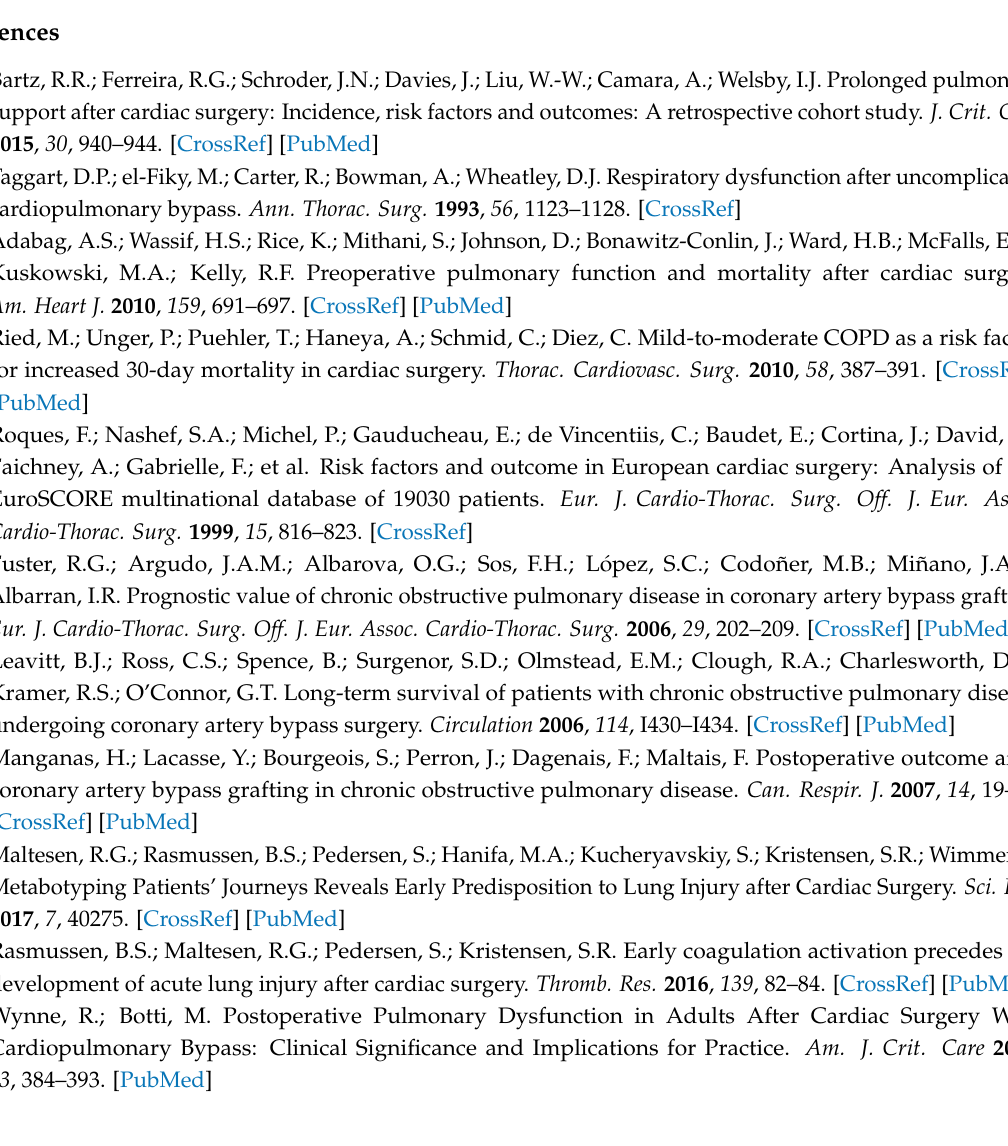
Table S1. Overview of metabolite changes with time in each corresponding